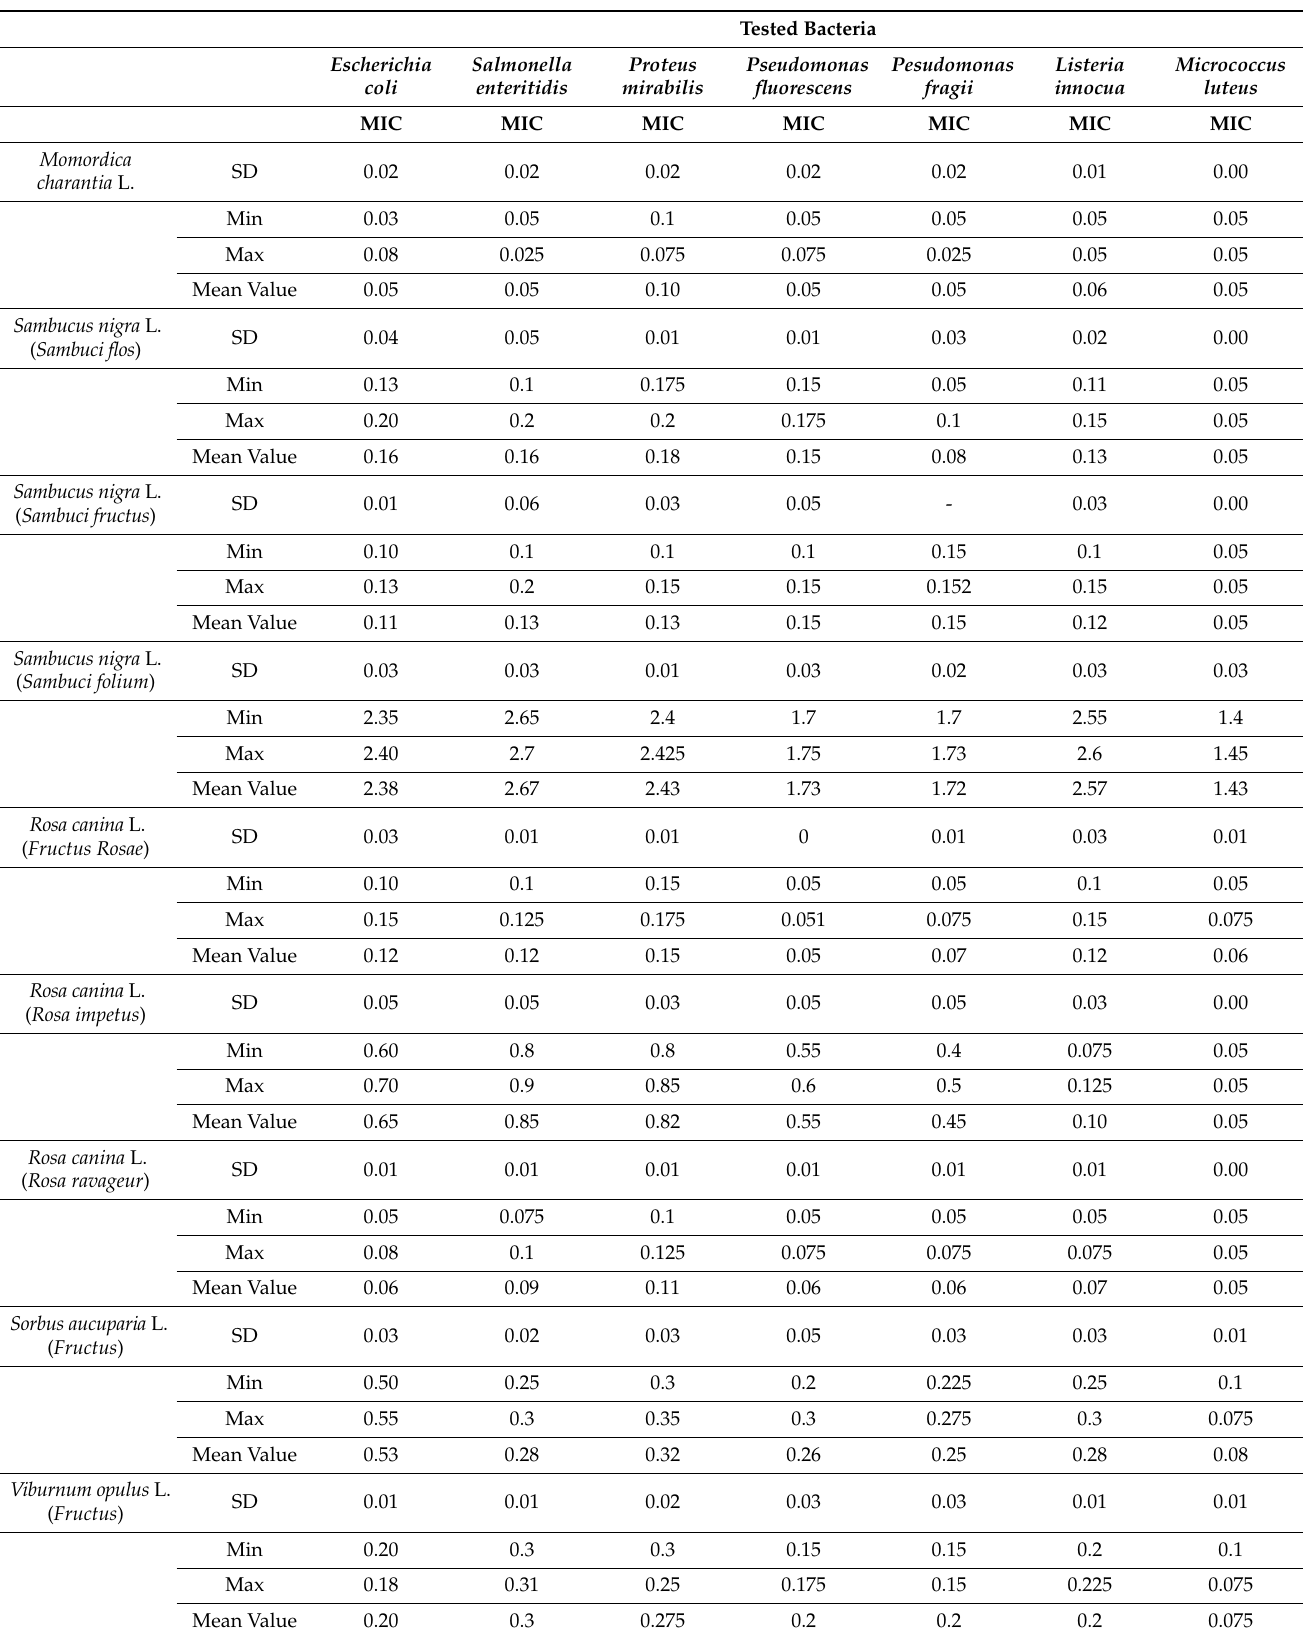
Table 2. The minimum inhibitory concentrations (MICs) [%] of the plants’ extracts. Tested